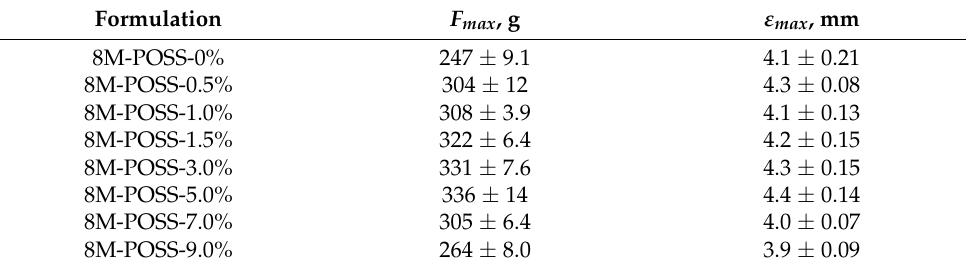
Table 4. Mechanical properties of ionogels with 70 wt.% of EMImNTf 2 + PC. Formulation